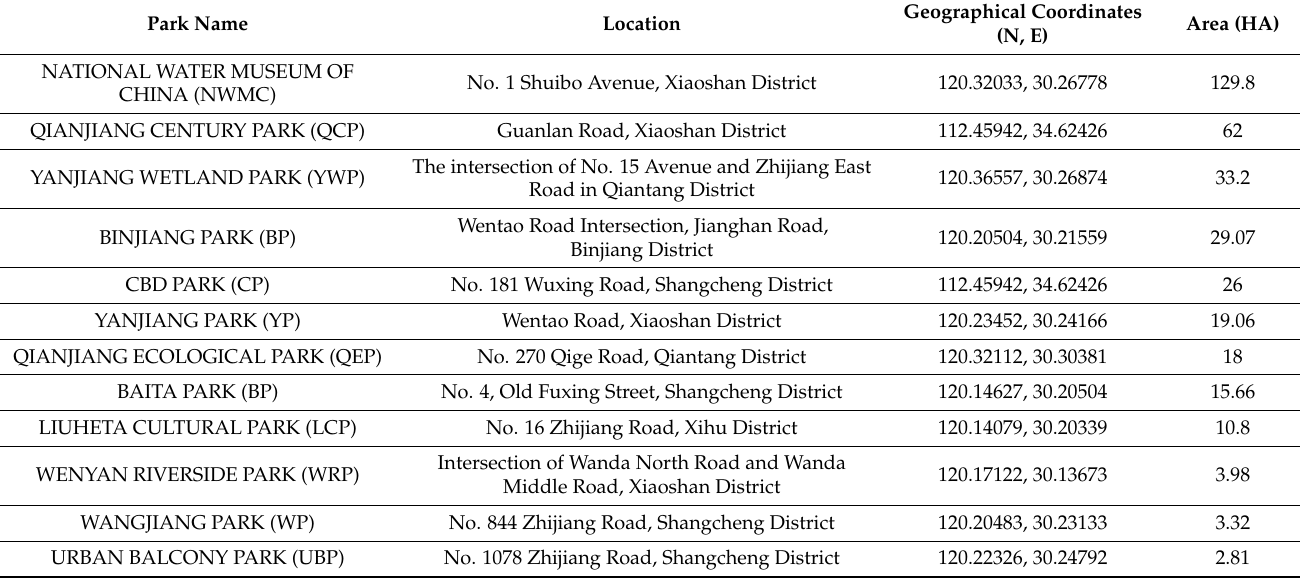
Table 1. Location and area of the waterfront parks (Hangzhou City, Zhejiang